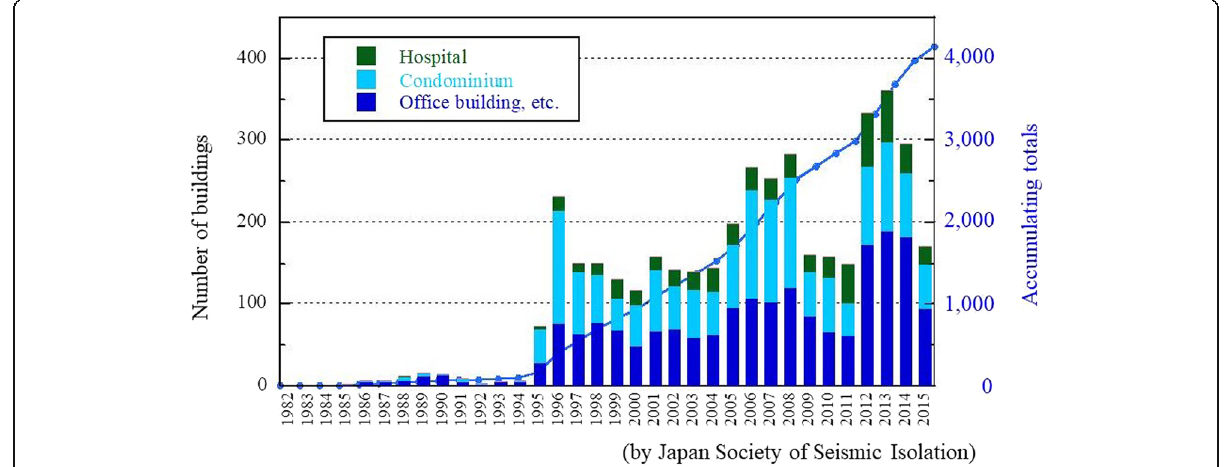
Fig. 12 Application of seismic isolation method in Japan